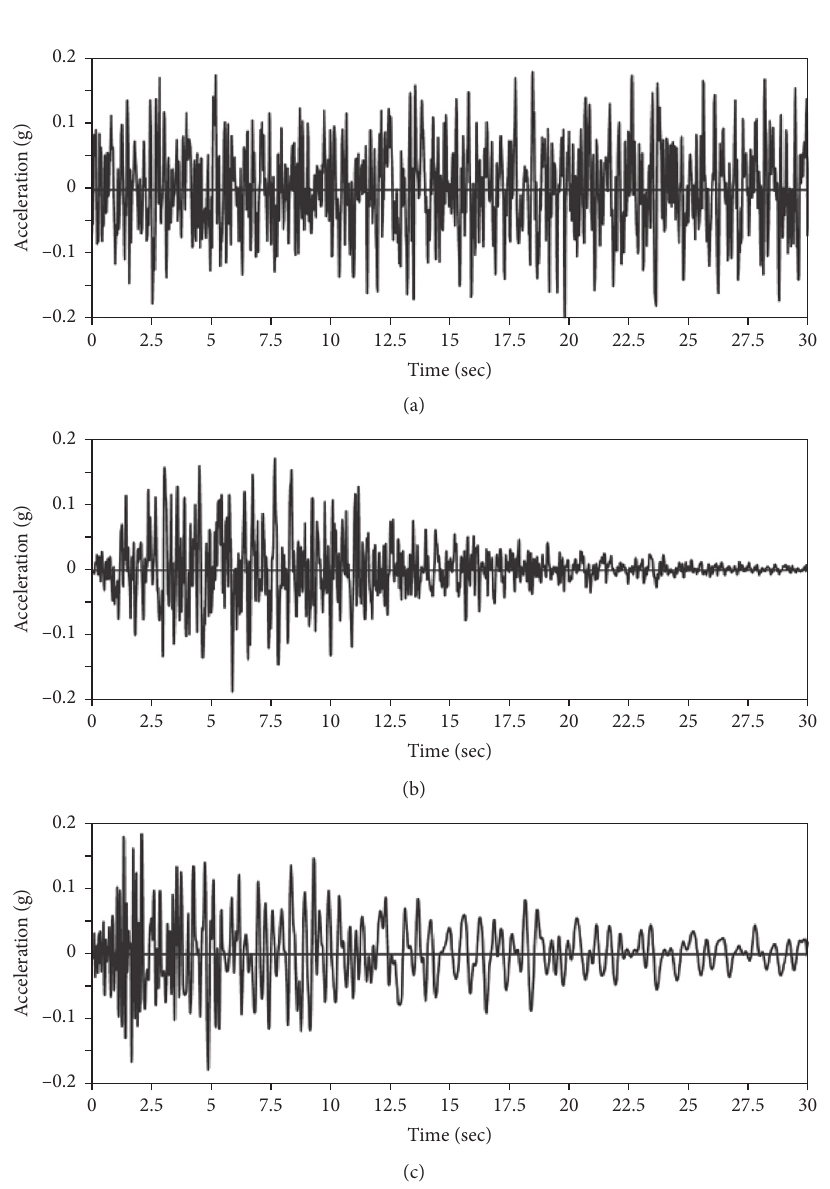
Figure 2: Examples of accelerograms belonging to the three sets used for this investigation: (a) stationary, (b) nonstationary evenly modulated, and (c) fully